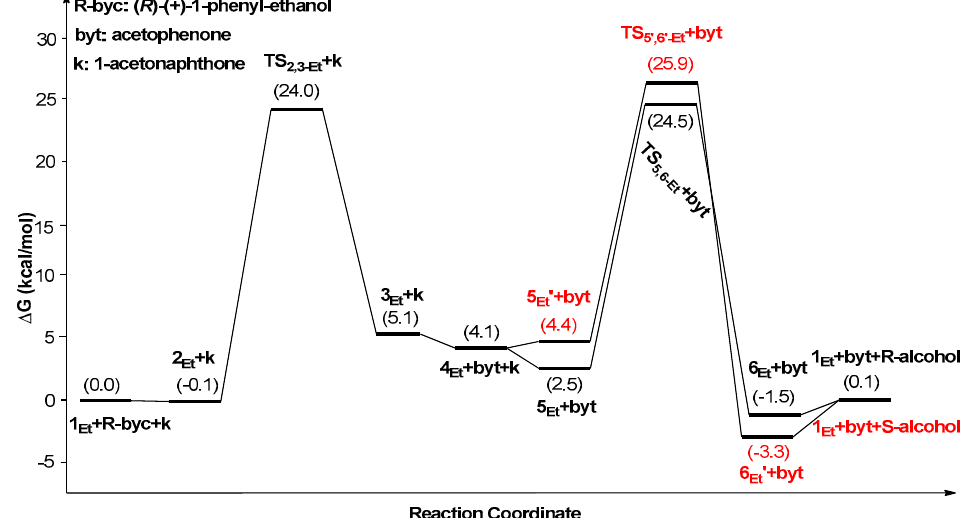
Figure 5. Relative free energy profile for the asymmetric transfer hydrogenation catalyzed by 1 Et.